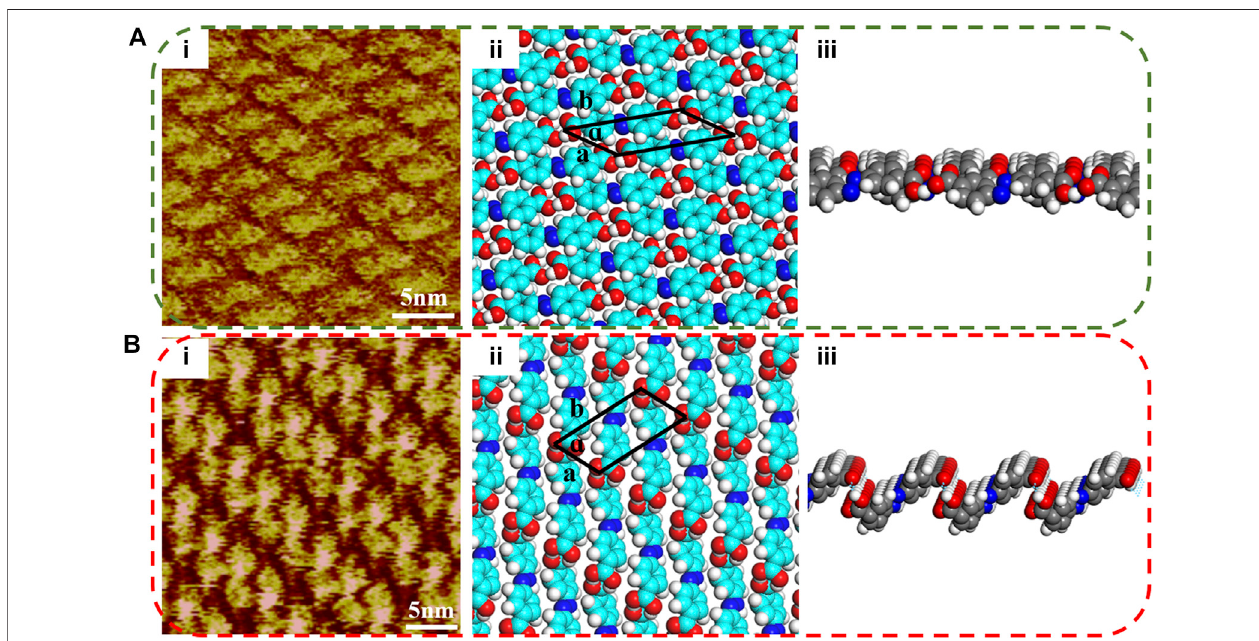
FIGURE 2 | STM images of the NN2A self-assembly template networks structures at the HOPG interface under light irradiation. (A) NN2A: (i) High resolution; (ii) The simulated molecular packing structure; (iii) 3D structural front view of NN2A molecular layer. (B) NN2A-uv: (i) High resolution; (ii) The simulated molecular packing structure; (iii) 3D structural front view of NN2A-uv molecular layer. Tunneling conditions: I set (cid:2) 290 pA, V bias (cid:2) 620 mV. The irradiation time of UV lamp with 360 nm is 40 min, and the power is 8 W/m.